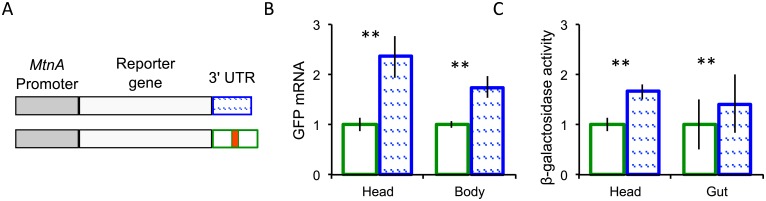
Reporter gene constructs and their expression.(A) The gray boxes represent the MtnA promoter, which is identical between the African and European alleles. The white boxes represent the GFP/lacZ reporter genes. The blue hatched box represents the MtnA 3’ UTR with the deletion. The green box represents the MtnA 3’ UTR with the additional 49 bp marked in red. The same color scheme applies to the bar plots. (B) The two versions of the GFP reporter gene differ significantly in expression in heads (t-test, P = 0.0019) and bodies (t-test, P = 0.0046), as assayed by qRT-PCR. (C) The two versions of the lacZ reporter gene differed significantly in expression in heads (t-test, P = 0.0006) and guts (t-test, P = 0.0001) as measured by β-galactosidase enzymatic activity. The error bars represent the standard error of the mean.